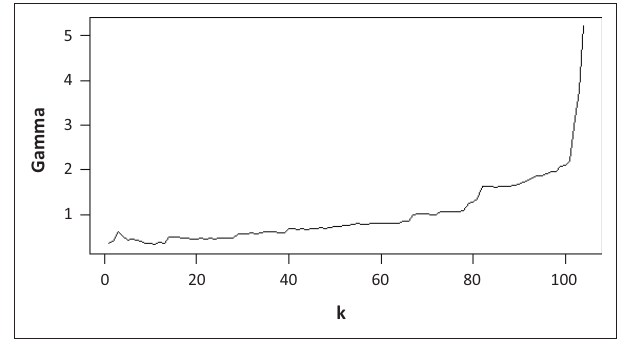
FIGURE 22: Kenya – Hill estimate to obtain cut-off between tail and central